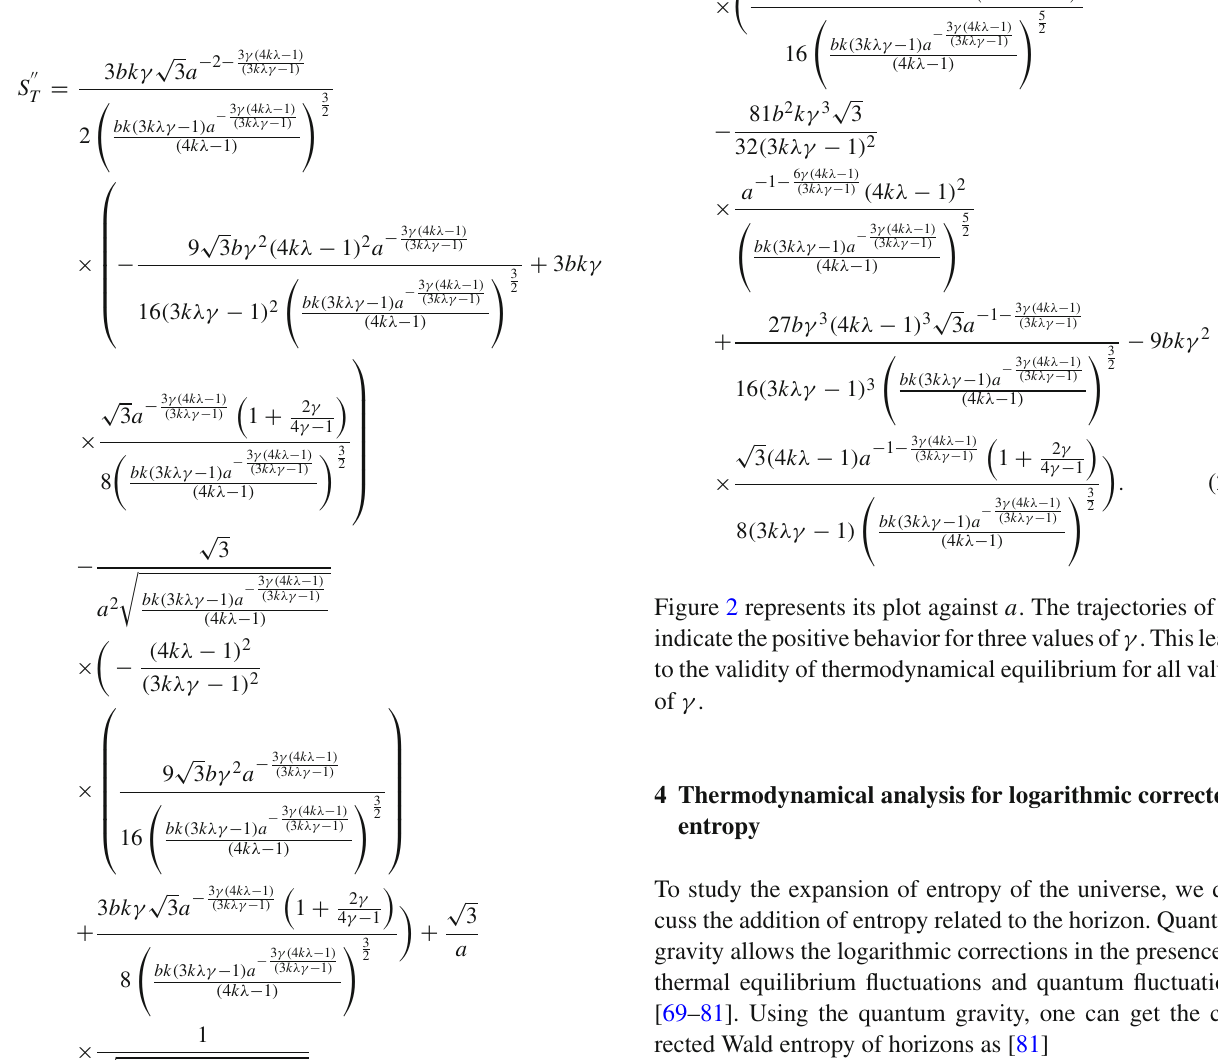
(cid:7)(cid:7) S T